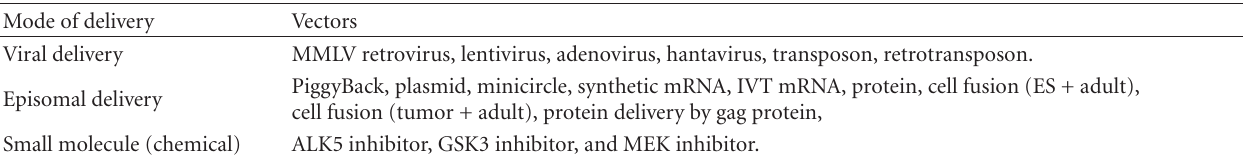
Table 2: Nuclear reprogramming factor delivery. List of reprogramming factors delivery by various methods shown in Table 2. Mode of